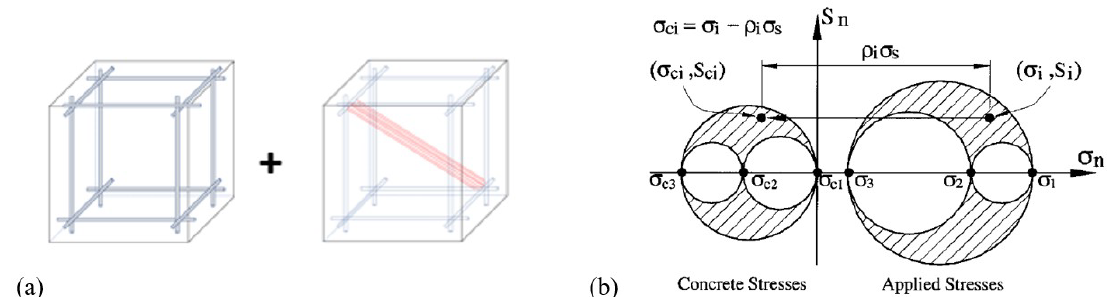
Figure 8. (a) System of resistance for a reinforced solid; (b) Mohr´s circle for the applied stresses and equivalent stresses on concrete and reinforcement [11]